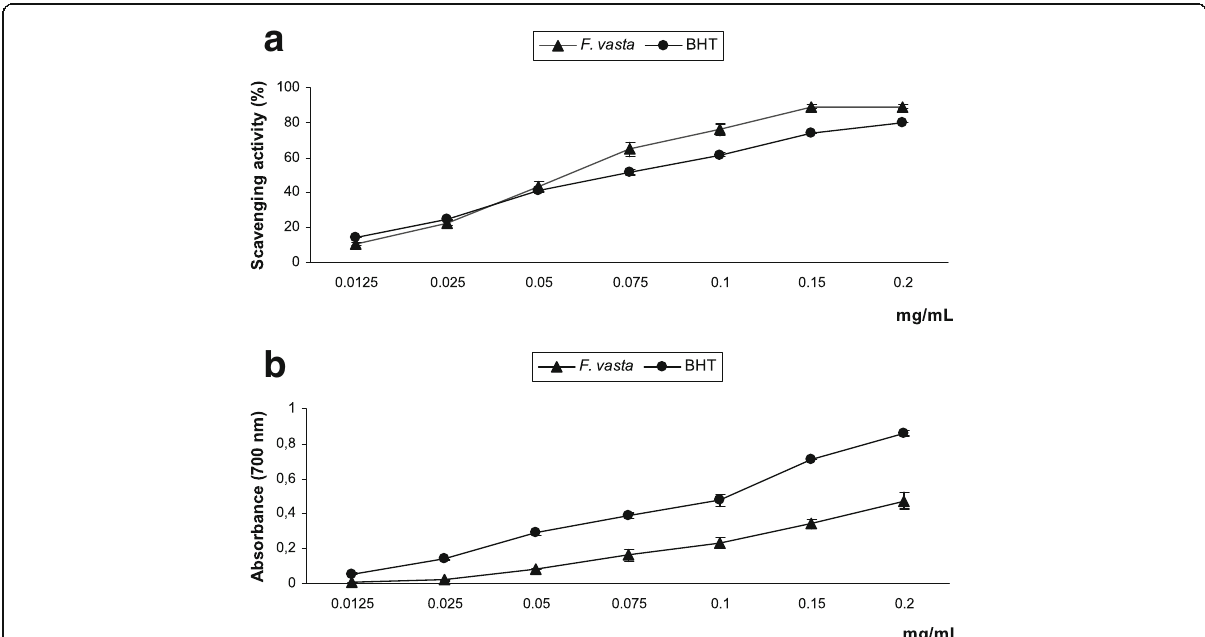
Fig. 2 Free radical scavenging activity (DPPH test) ( a ) and reducing power ( b ) of F. vasta leaves hydroalcoholic extract. Values are expressed as the mean ± SD ( n =